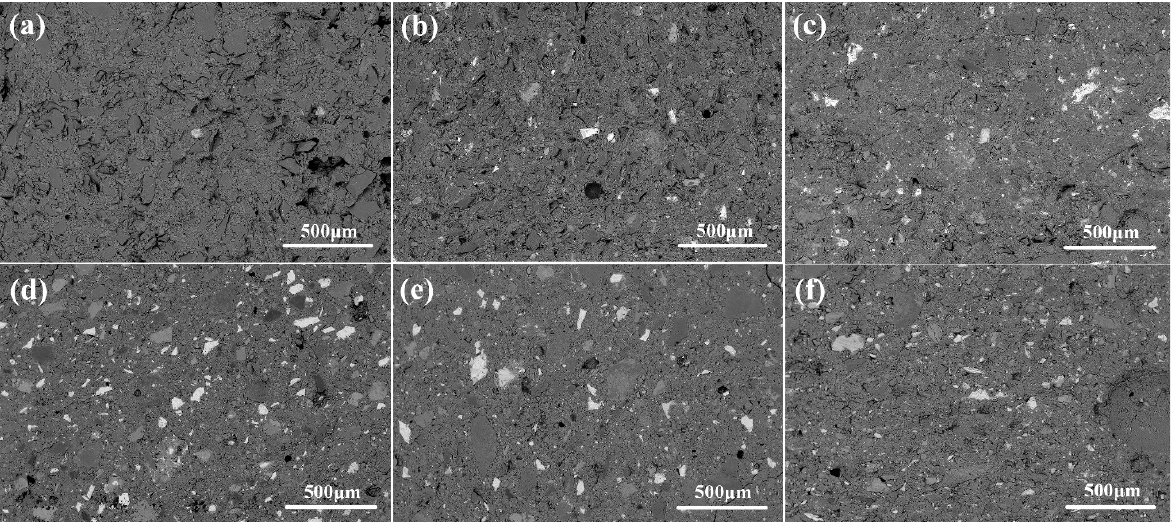
Figure 3. BSE images of 28 d MASM mortars: ( a ) M0S; ( b ) M5S; ( c ) M10S; ( d ) M13S; ( e ) M15S; ( f ) M20S.